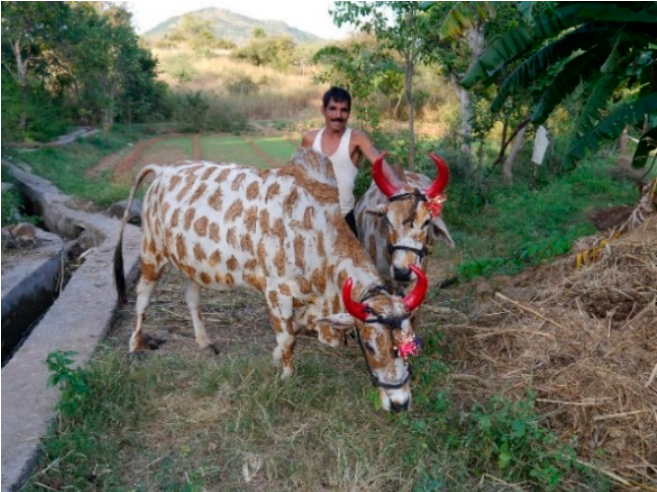
Figure 2. Farmer with his decorated and venerated bulls, Havala 2017 (picture by author).